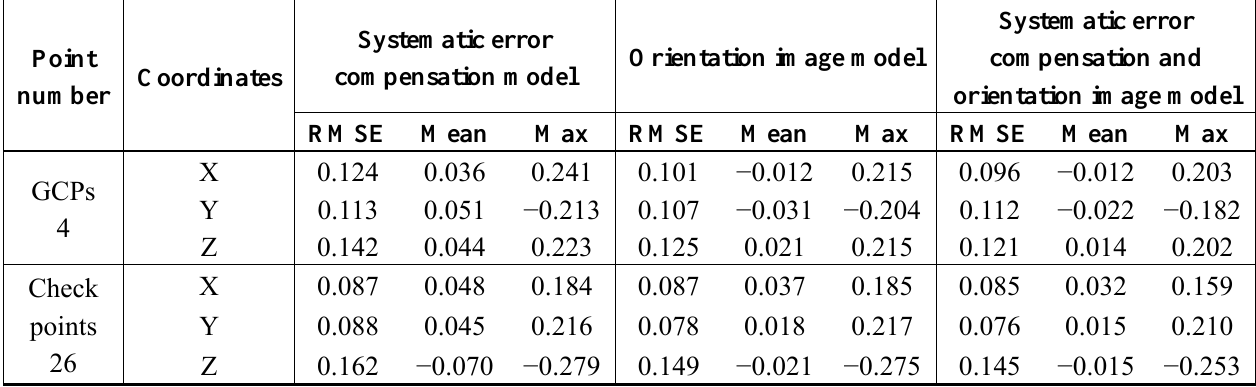
Table 3. Error statistics of bundle adjustment of Waldkirch test field (Unit: